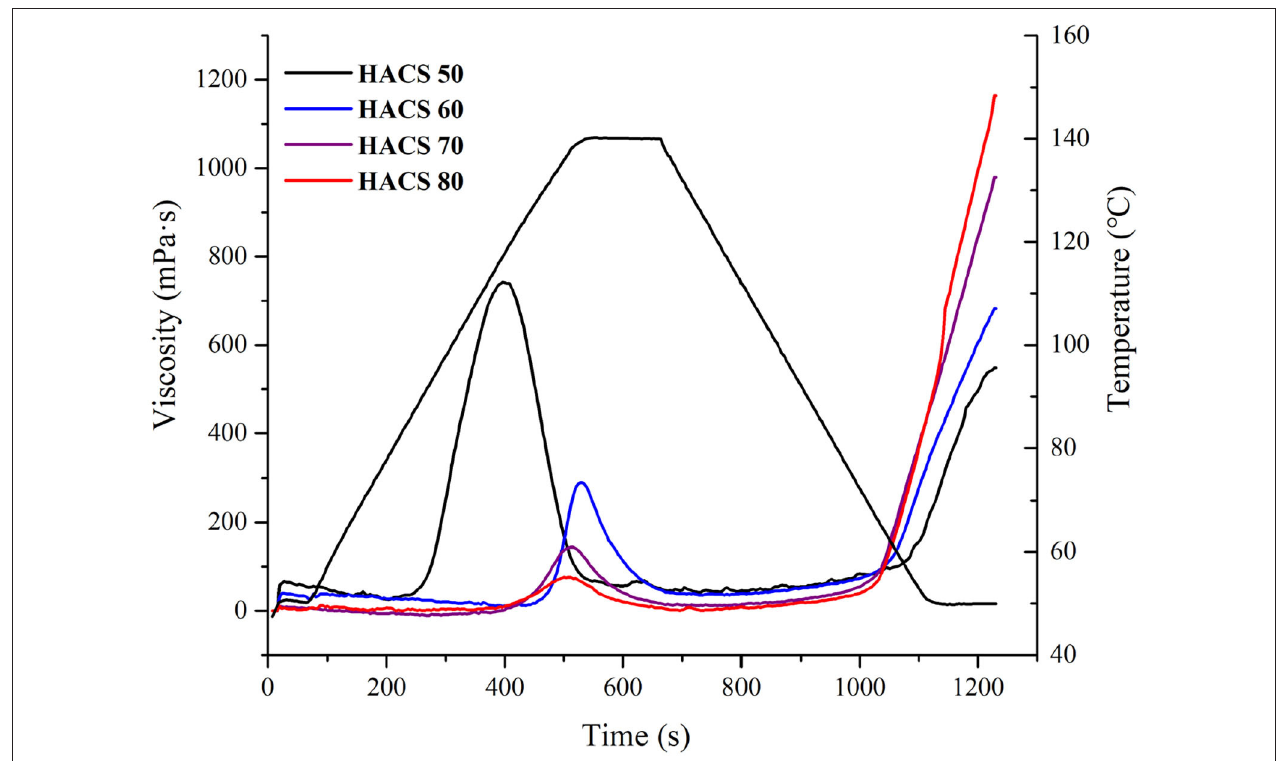
FIGURE 3 | RVA pasting profiles of HACS with different amylose content.